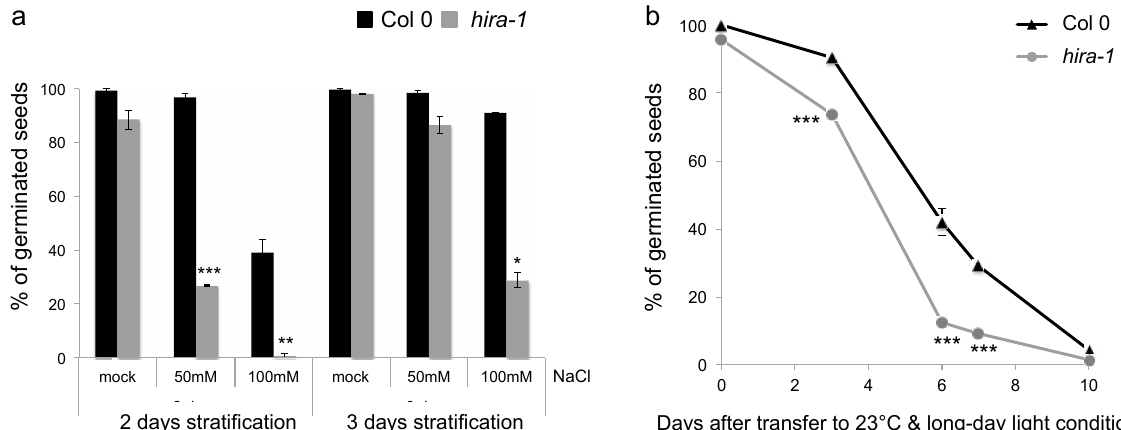
Figure 6. Germination of hira-1 mutant seeds is affected by salt stress and is sensitive to storage in a high temperature and humidity. ( a ) Germination of Col 0 (black) and hira-1 (grey) seeds under long-day conditions at 23 °C in presence of 50 mM or 100 mM NaCl after two or three days of stratification at 4 °C in darkness. Means of two biological replicates with SEM are shown. ( b ) Germination of Col 0 (black) and hira-1 (grey) seeds under long-day condition at 23 °C after exposure of dry seeds for 4, 6, 7 or 10 days to 80% relative humidity at 37 °C. Seeds were stratified for three days at 4 °C in darkness and germinated seeds scored six days after transfer to light. Means of four biological replicates with SEM are shown. Statistically significant differences relative to wild type seeds were determined using a two-sided Student’s t -test (* p < 0.05, ** p < 0.01, *** p < 0.001).